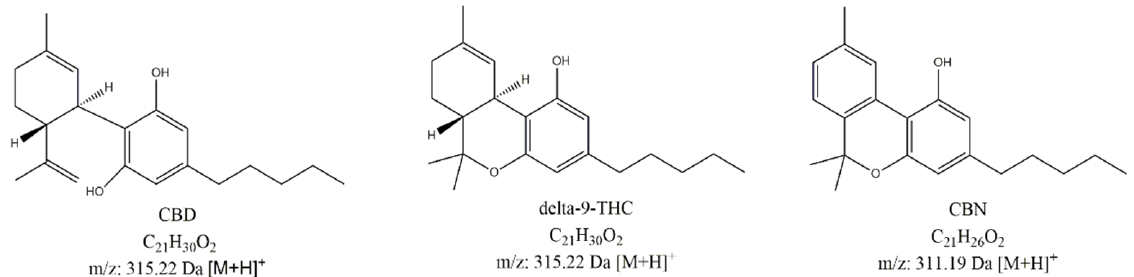
Figure 1. Chemical structures of active ingredient cannabidiol (CBD) and its possible degradation products ( Δ 9 -tetrahydrocannabinol ( Δ 9 -THC) and cannabinol